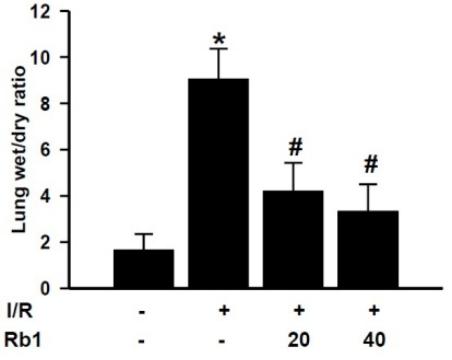
Figure 5. Effects of Rb1 on lung wet weight to dry weight ratio.